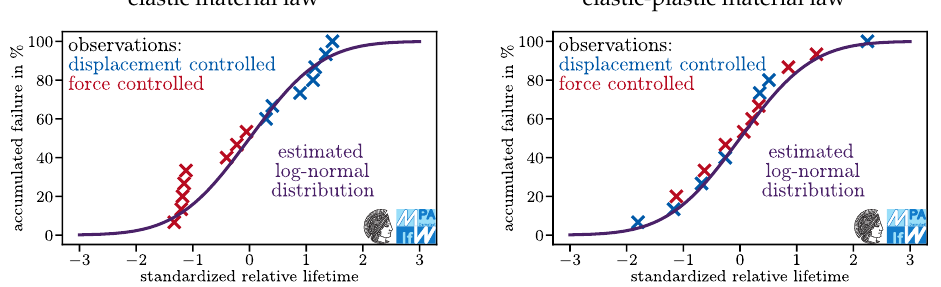
Figure A2. Estimated and observed accumulated failure rates for 50CrMo4 specimens in laboratory air; 919MPa ultimate tensile strength; K t = 1.75.